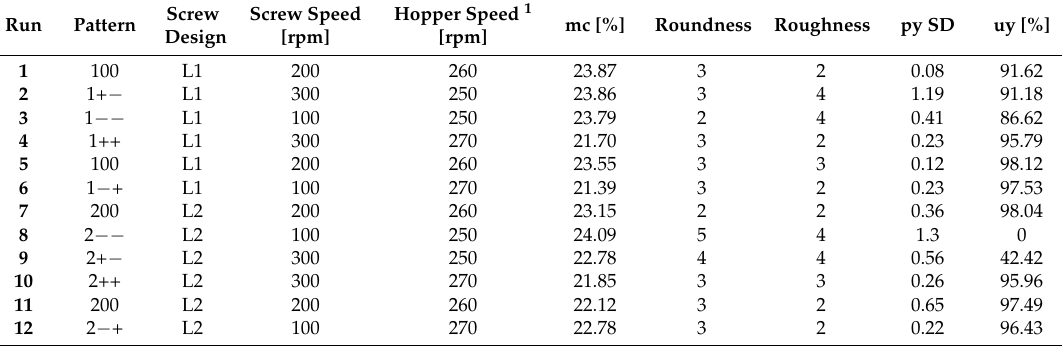
Table 1. Design of Experiment of the extrusion process and the resulted responses (for all runs the spheronisation process was constant with 9 min time, 75% speed and 15 g load). Run Pattern